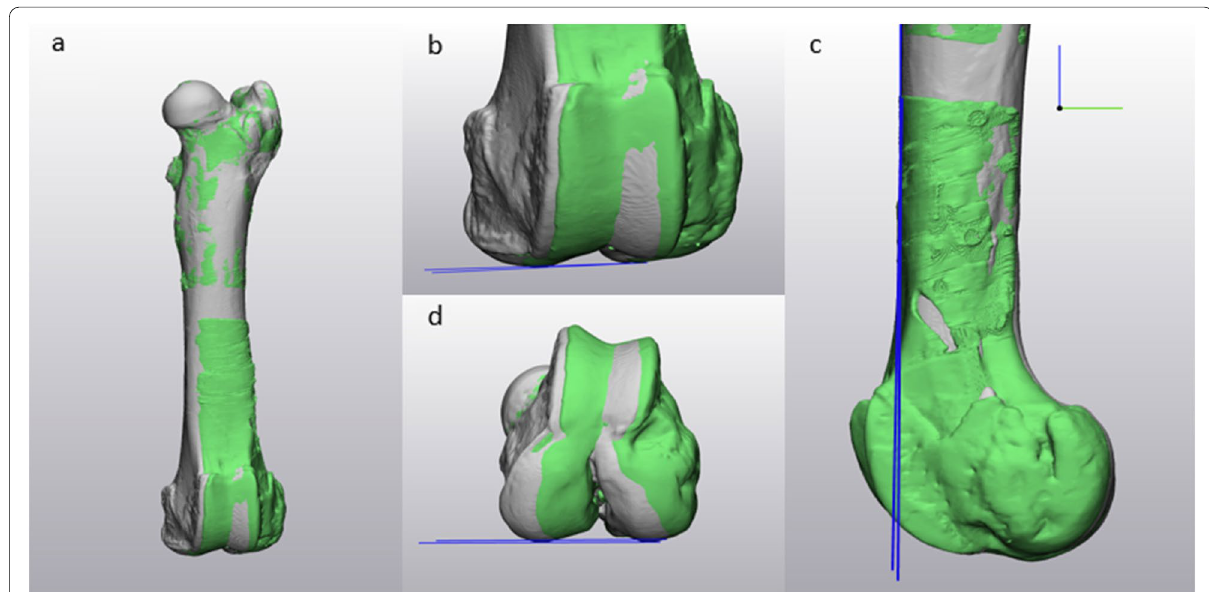
Fig. 7 Comparison of postoperative result to the preoperative plan of the femur with Materialise 3-matic software. Each picture shows two porcine femoral bone models. The preoperative model is grey while the achieved result is green. Both models were fitted proximally (automatic registration, a ). Subsequently, the measurements of varus/valgus ( b ), procurvatum/recurvatum ( c ) as well as rotation ( d ) were performed distally. The blue lines indicate a tangent to each of the bone at defined points. For varus/valgus and rotation a tangent to the most distal point of the medial and lateral distal femoral condyle was drawn. For procurvatum/recurvatum, the tangent was fitted to the anterior femoral cortex on a lateral view. The angle between these lines represents the respective deviation from the plan